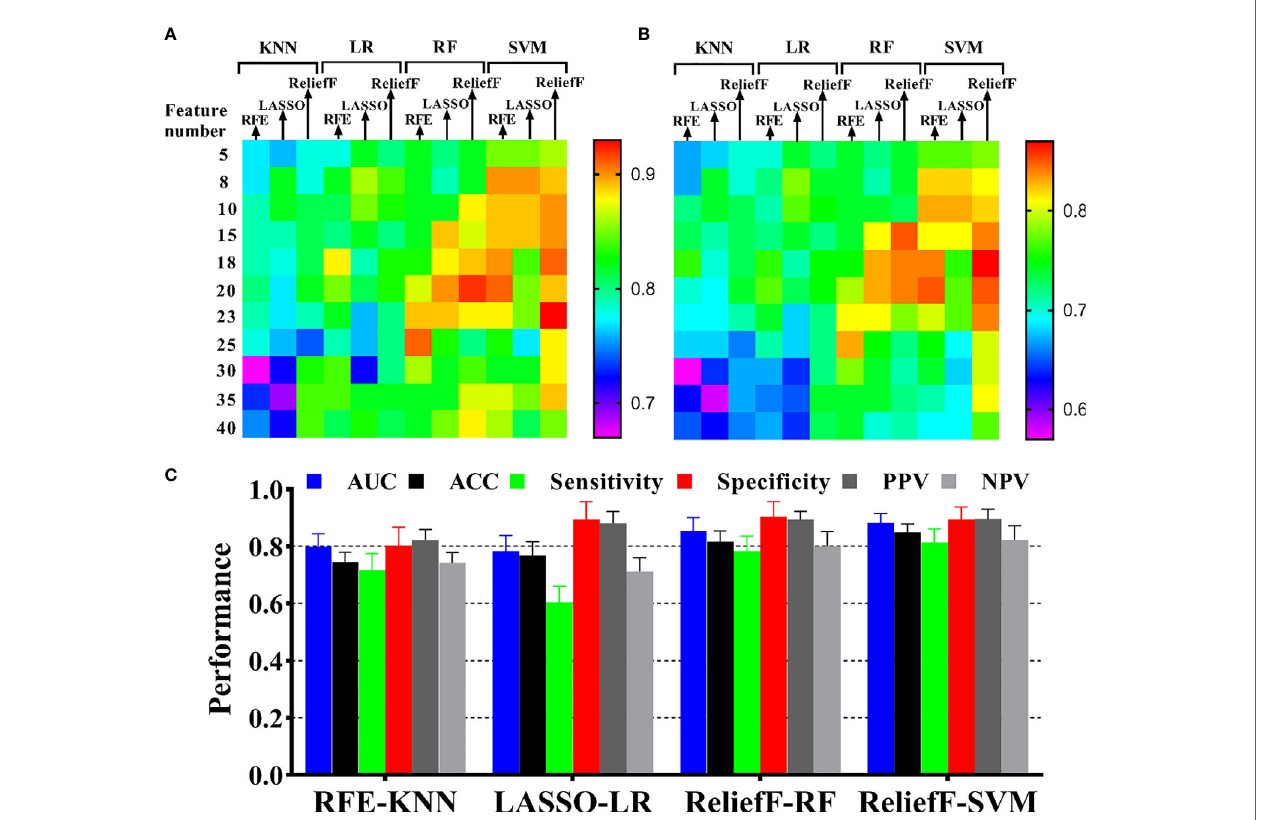
FIGURE 4 | Performance of HIFU ablation prediction with different machine learning methods. The heatmaps show the AUCs of model with four classi fi ers and three feature selection methods in different feature numbers for (A) the primary cohort and (B) the validation cohort. The annotation of the heatmap (located to the right of the entire image) illustrates that red or yellow represents a high AUC and pink or blue represents a low AUC. (C) Model performance presentation for the four optimal combinations of feature selection and machine learning in the validation